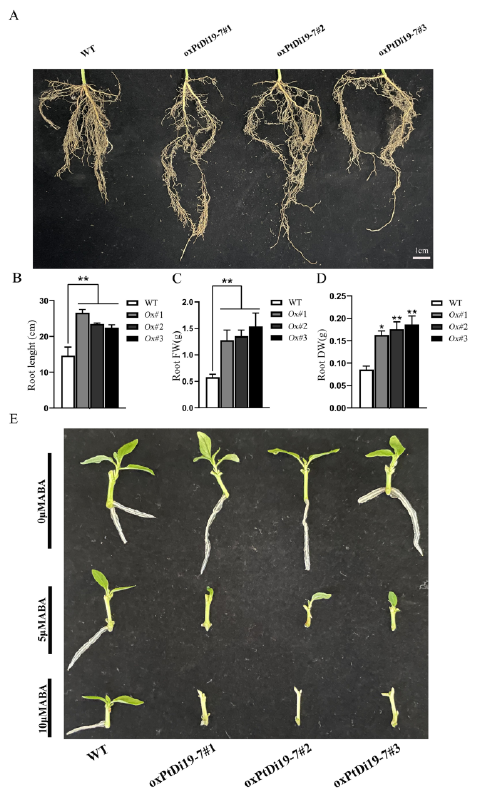
Figure 10. PtDi19–7 affects root development of transgenic poplar and responds to exogenous ABA. ( A ) Phenotypic analysis of root length after 8 days of drought treatment. ( B ) The root length measure- ment. ( C ) The root fresh weight. ( D ) The root dry weight. ( E ) Lateral bud outgrowth of short shoot segments grown for 3 weeks on 1/2 MS medium supplemented with ABA (5/10 µ M) or without ABA of WT and oxPtDi19–7 plants. A p -value of <0.05 was considered to be significant (*), and a p -value of <0.01 was considered to be extremely significant